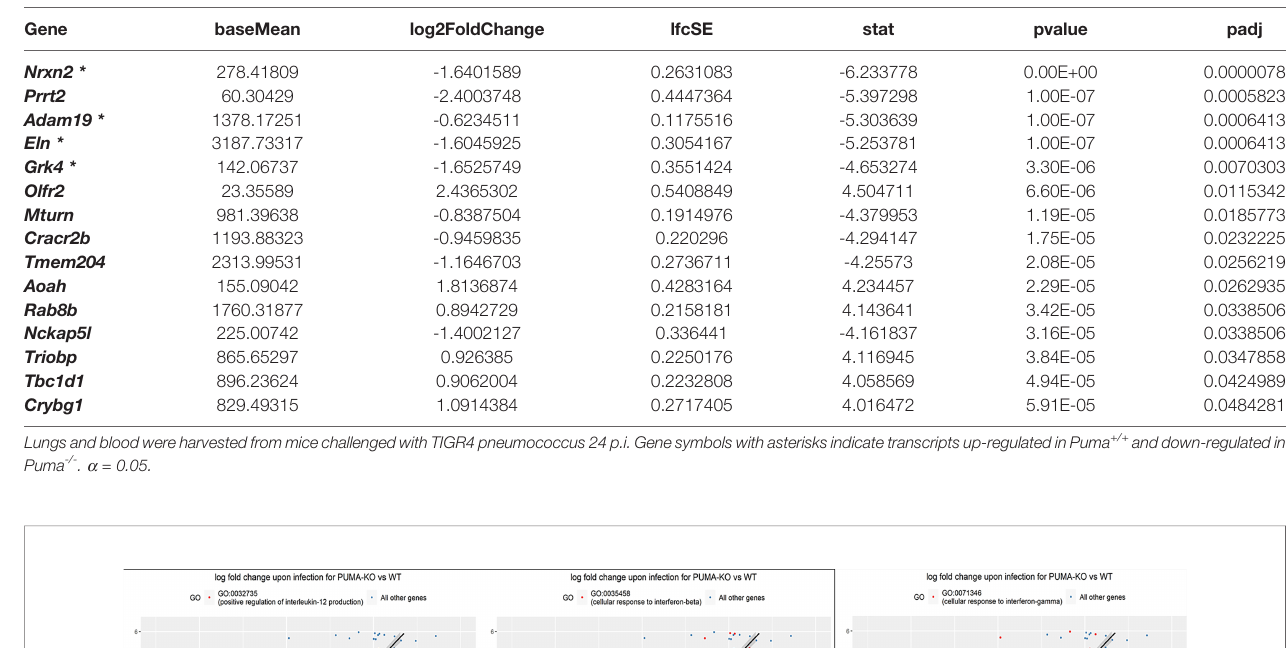
TABLE 3 | Differentially expressed genes in Puma -/- lungs.